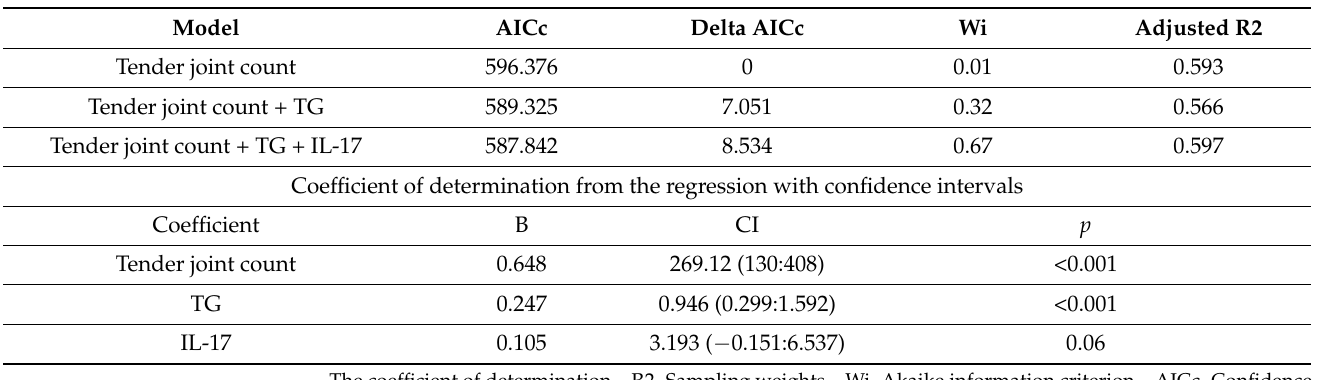
Table 3. Linear regression model for IL-18 in perPsA group ( n = 47).